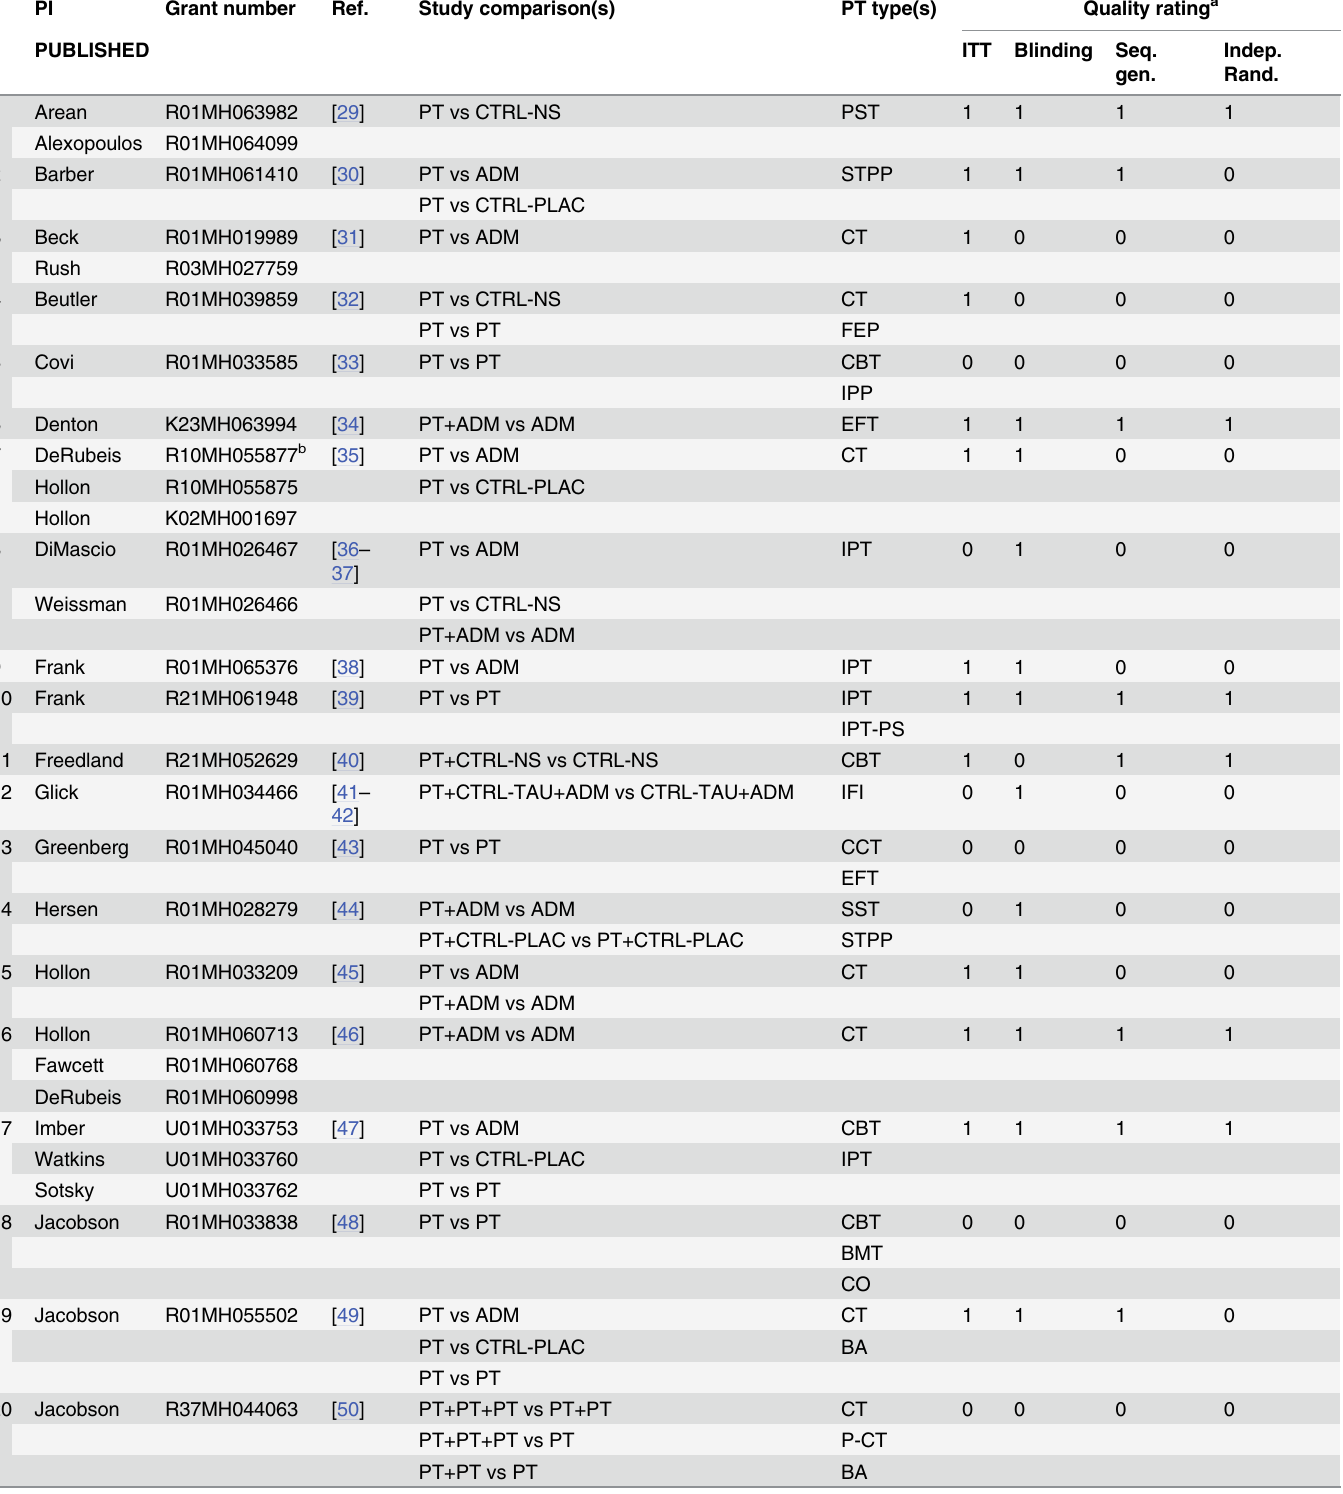
Table 1. Characteristics of the included